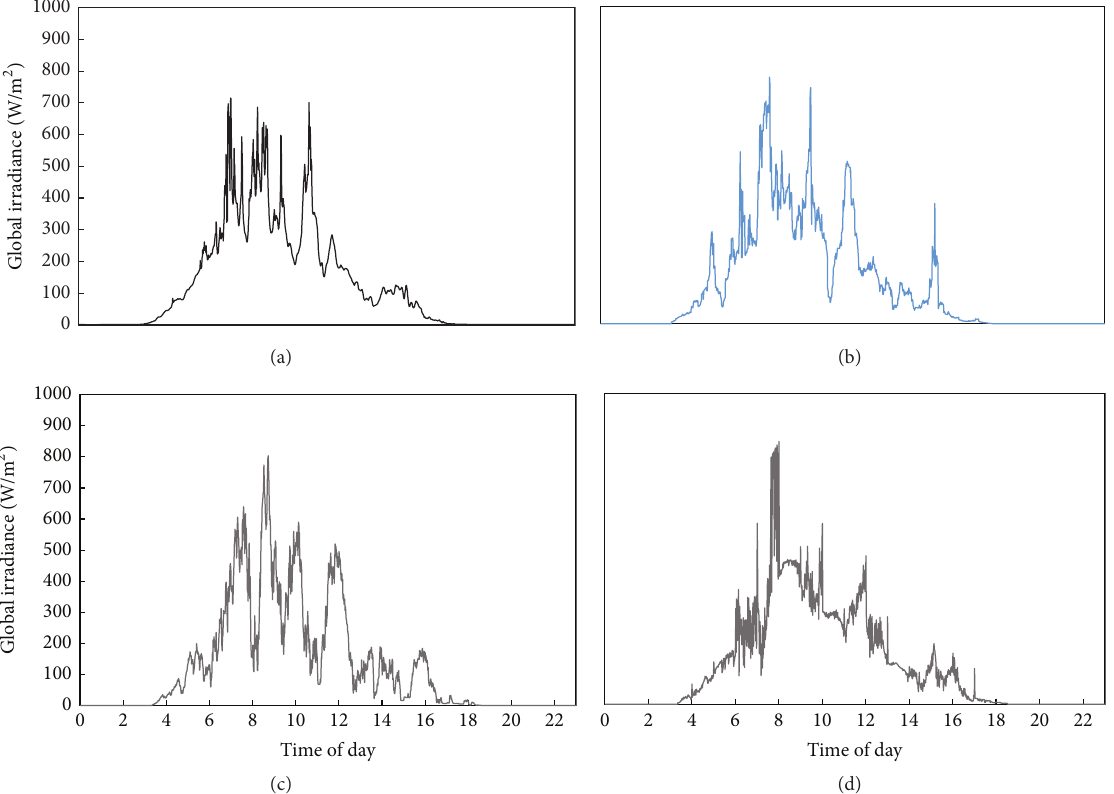
Figure 5: Lindenberg, May 14, 2005. The temporal course of the measured global irradiance (a) on a day that was rated as a day with overcast sky is compared to values generated by the new algorithm (b), the algorithm by Aguiar (c), and the algorithm by Skartveit (d). The mean variability, that is, the mean irradiance change from one minute to the next, of the measured irradiance of 7.0W/m 2 shows good congruence with the new algorithm (8.2 W/m 2 ), while the usage of the algorithms by Aguiar and Skartveit leads to higher variability values of 13.1W/m 2 and 16.6W/m 2 .